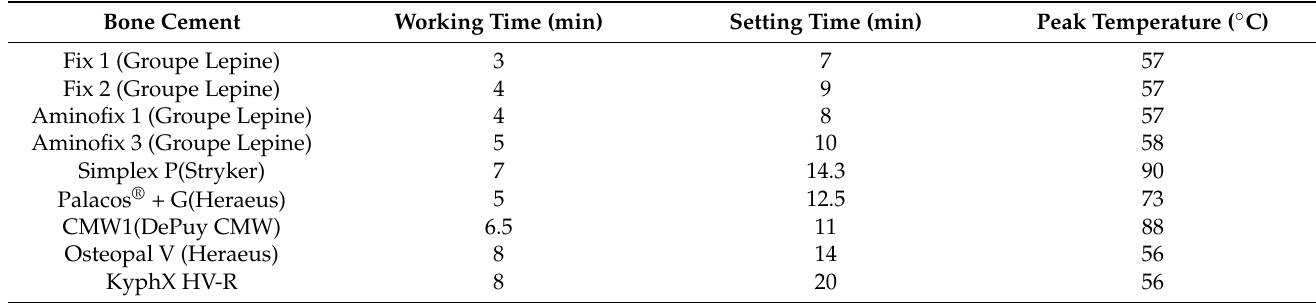
Table 1. Stabilization parameters of some commercial acrylic bone cements [59,60].